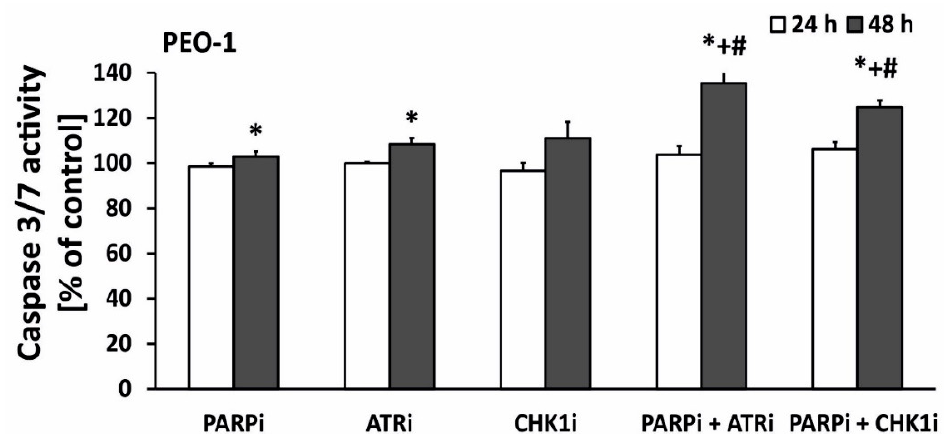
Figure 4. ATRi / CHK1i combined with PARPi increases apoptosis. Caspase 3 / 7 expression was used as an indicator of apoptosis in EOC cell lines exposed to 0.5 µ mol / L PARPi, 0.5 µ mol / L CHK1i, and 0.5 µ mol / L ATRi for 24 and 48 h. Untreated cells were used as controls and considered 100%. In SKOV-3 cells, apoptosis was increased by both ATRi in combination with PARPi (30%) and CHK1 combination with PARPi(22%)after48hoftreatment. InOV-90(p53MUT)cells, apoptosiswasincreasedafter24and48hof incubation with ATRi in combination with PARPi (16% and 17%, respectively) and CHK1 in combination with PARPi (13% and 9% respectively). In PEO-1 (BRCA2 MUT ) cells, apoptosis was increased by ATRi in combination with PARPi (35%) and CHK1 in combination with PARPi (24%) after 48 h of treatment. Error bars denote standard deviation, * indicates statistically significant di ff erences between the samples incubated with the drugs compared with control cells ( p < 0.05). + Statistically significant di ff erences between the samples incubated with PARPi and combination treatment (PARPi / ATRi; PARPi / CHK1i) ( p < 0.05). # Statistically significant di ff erences between samples incubated with ATRi or CHKi and combination treatment (PARPi / ATRi; PARPi / CHK1i). Statistical analysis was performed using the ANOVA test with the Tukey’s post-hoc test for multiple